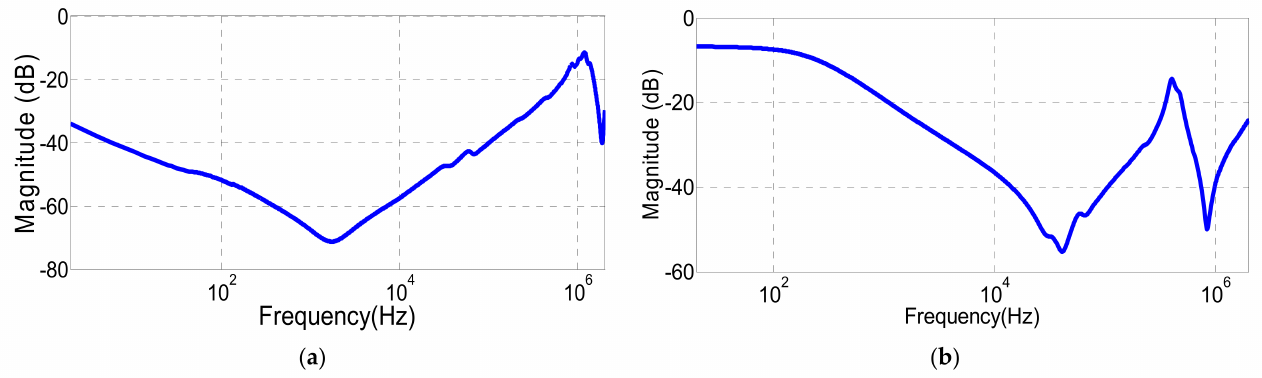
Figure 3. End—to—end measurement result from 500 kVA transformer: ( a ) open circuit test response, and ( b ) short circuit test response.